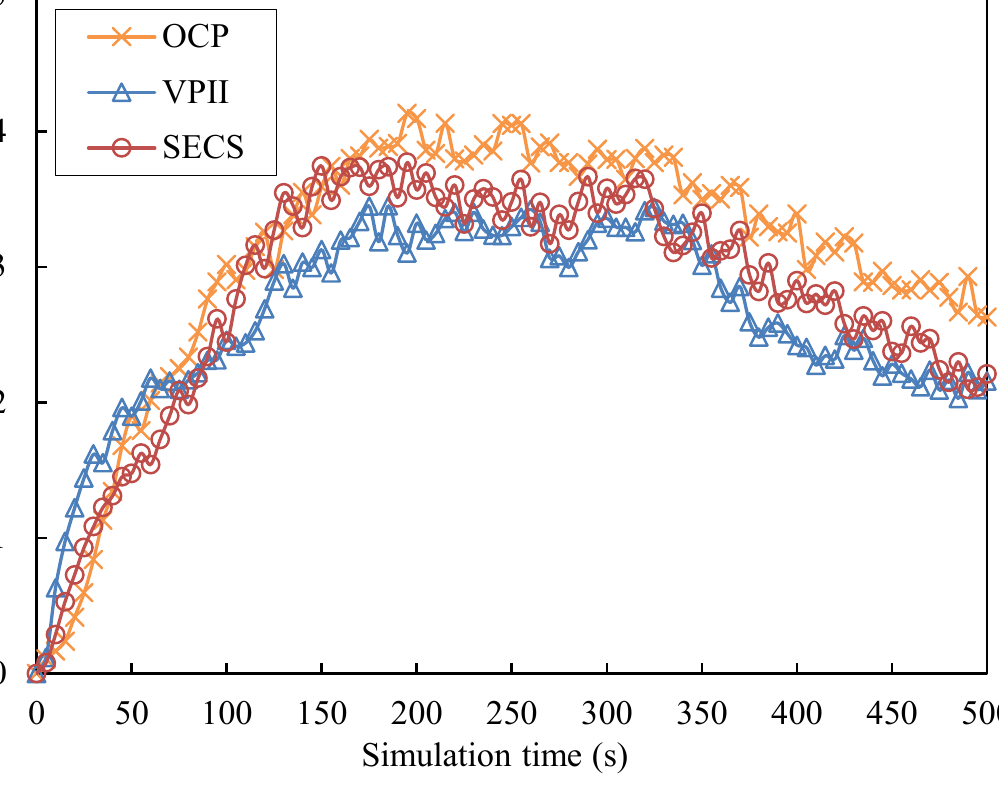
Figure 3. Startup delay against simulation